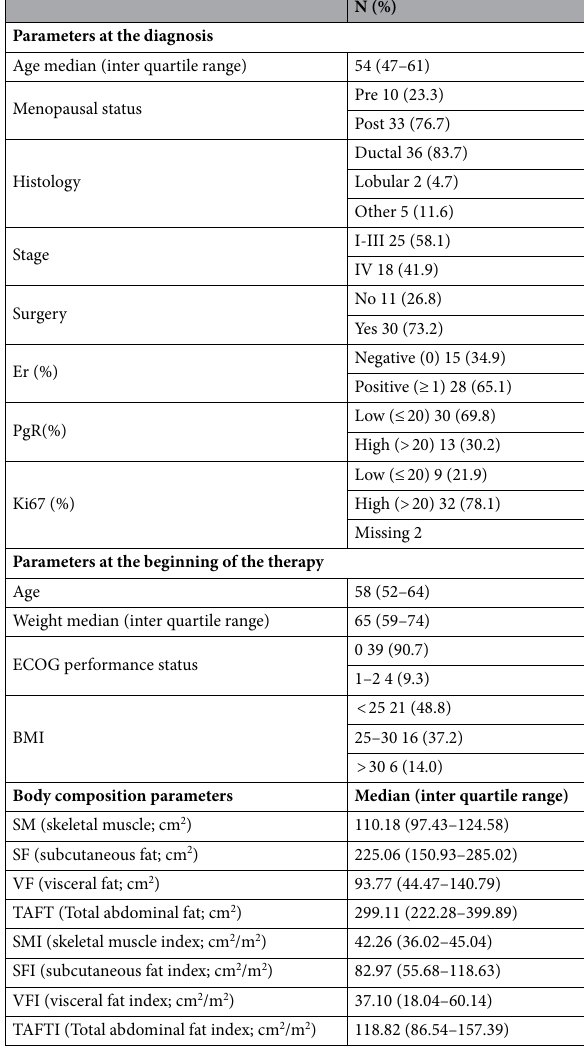
Table 1. Patients’ clinical and metabolic parameters at the diagnosis and at the beginning of the therapy.